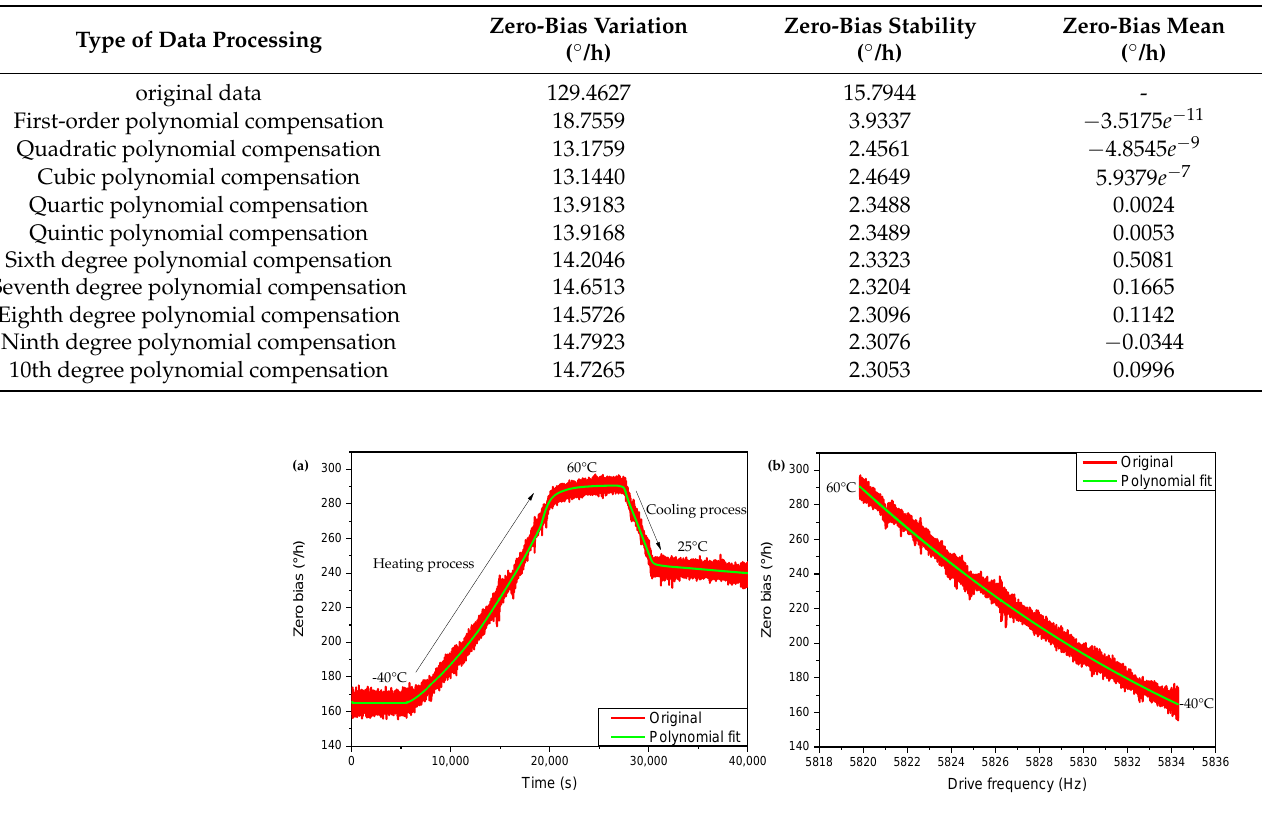
Figure 5. Zero-bias drift data under slowly changing temperature conditions, polynomial fit, and zero bias after compensation. ( a ) Zero-bias time curve. ( b ) Zero bias-drive frequency curve.